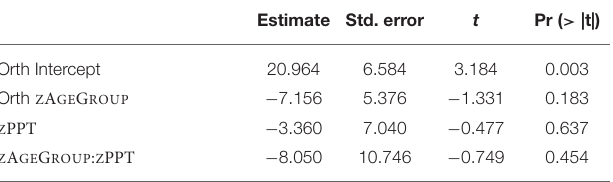
TABLE 7 | Lmer model for orthographic priming with fixed effects of Z A GE G ROUP and Z PPT , as well as their interaction. Estimate Std. error